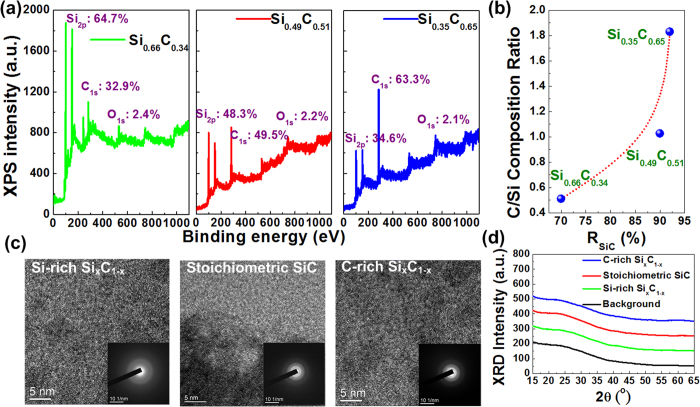
Material characteristic of SixC1−x film.(a) The XPS spectra of the Si-rich, the stoichiometric, and C-rich SixC1−x films. (b) The C/Si composition ratio of the SixC1−x film as a function of RSiC. (c) FETEM image, SAD pattern and (d) XRD spectra of the Si-rich, the stoichiometric, and C-rich SixC1−x films.